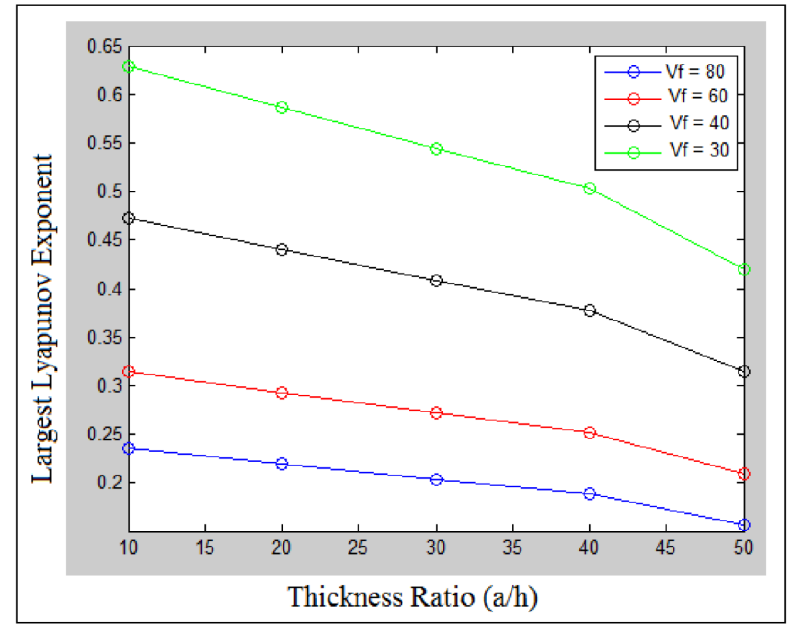
Figure 10. Largest Lyapunov exponent against thickness ratio for plate with one stiffener.